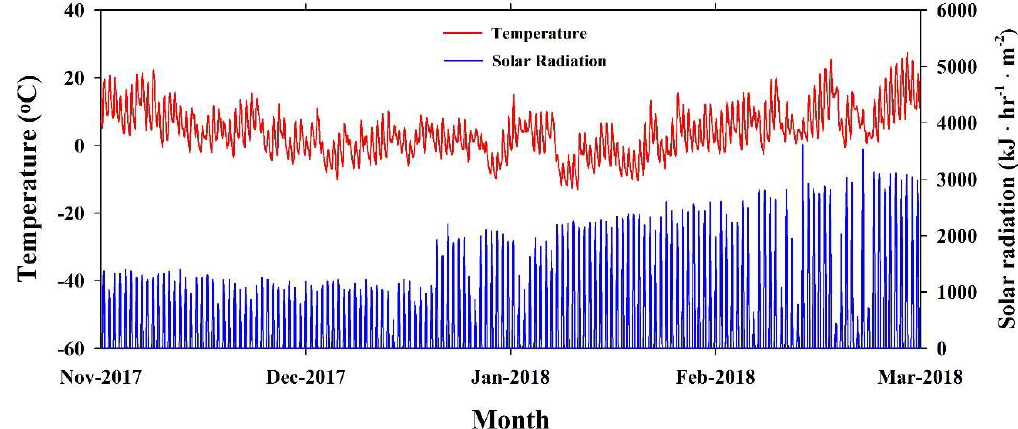
Figure 3. Greenhouse dimensions and positions of sensors [S (solar radiation), T (temperature & humidity), W1 (Wind speed), and W2 (Wind direction)] in the experimental greenhouse.